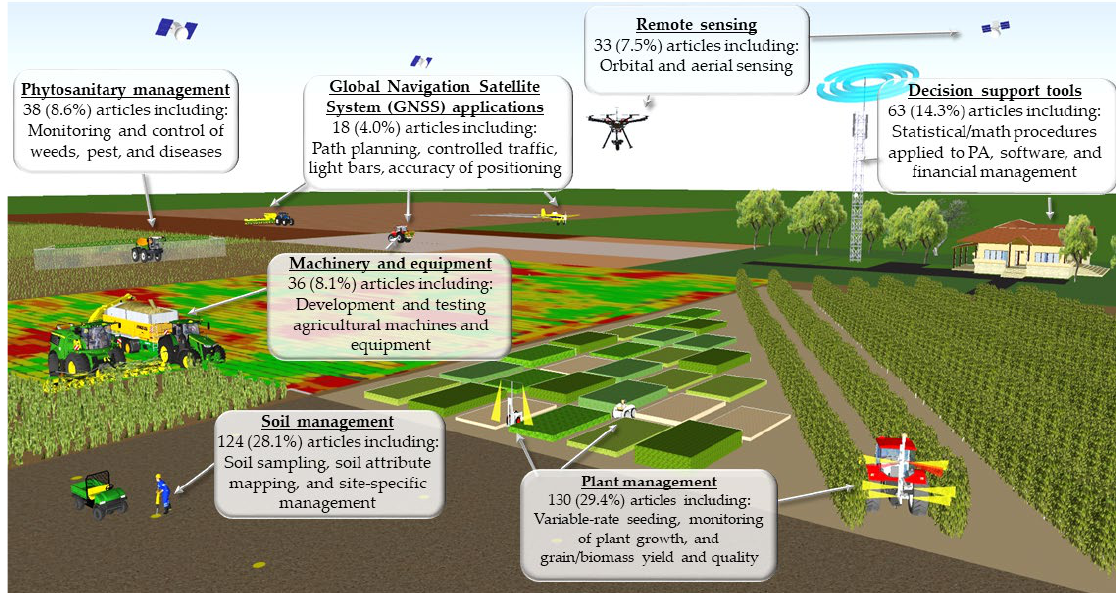
Figure 7. Precision agriculture research areas and their absolute and relative contributions to the total of publications included in this